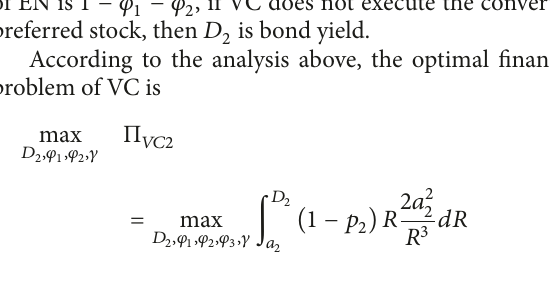
of EN is 1 − 𝜑 1 − 𝜑 2 , if VC does not execute the convertible preferred stock, then 𝐷 2 is bond